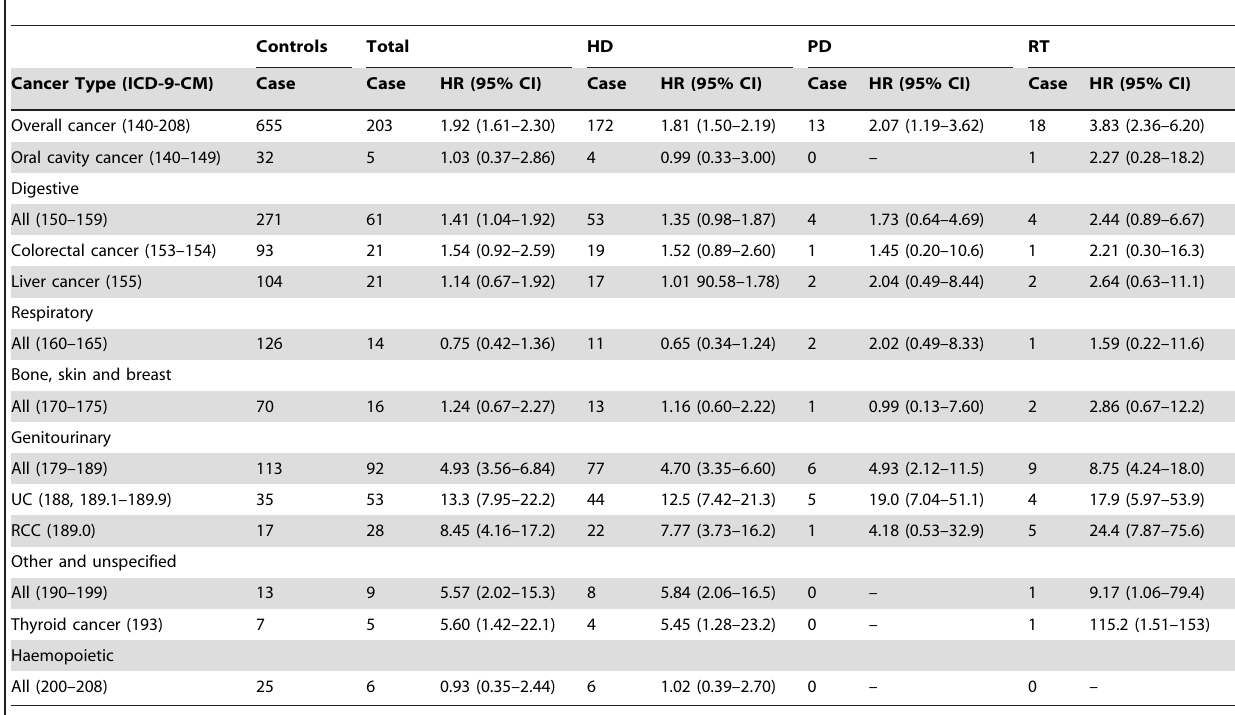
Table 3. Hazard ratios and 95% confidence interval of cancer risks associated with end-stage renal disease in Cox’s regression analysis in different cancers.